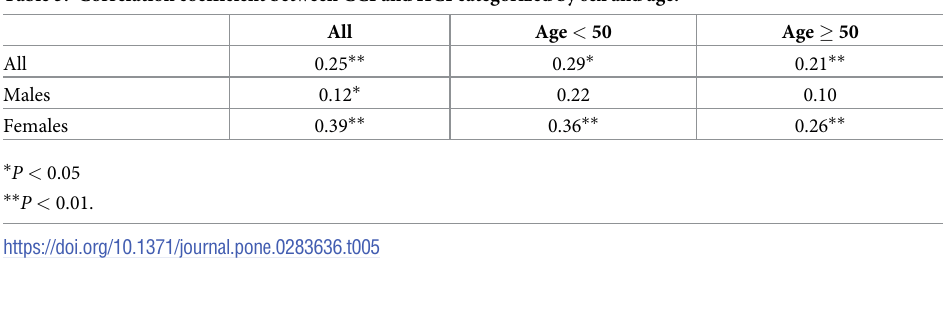
Table 5. Correlation coefficient between CCI and HCI categorized by sex and